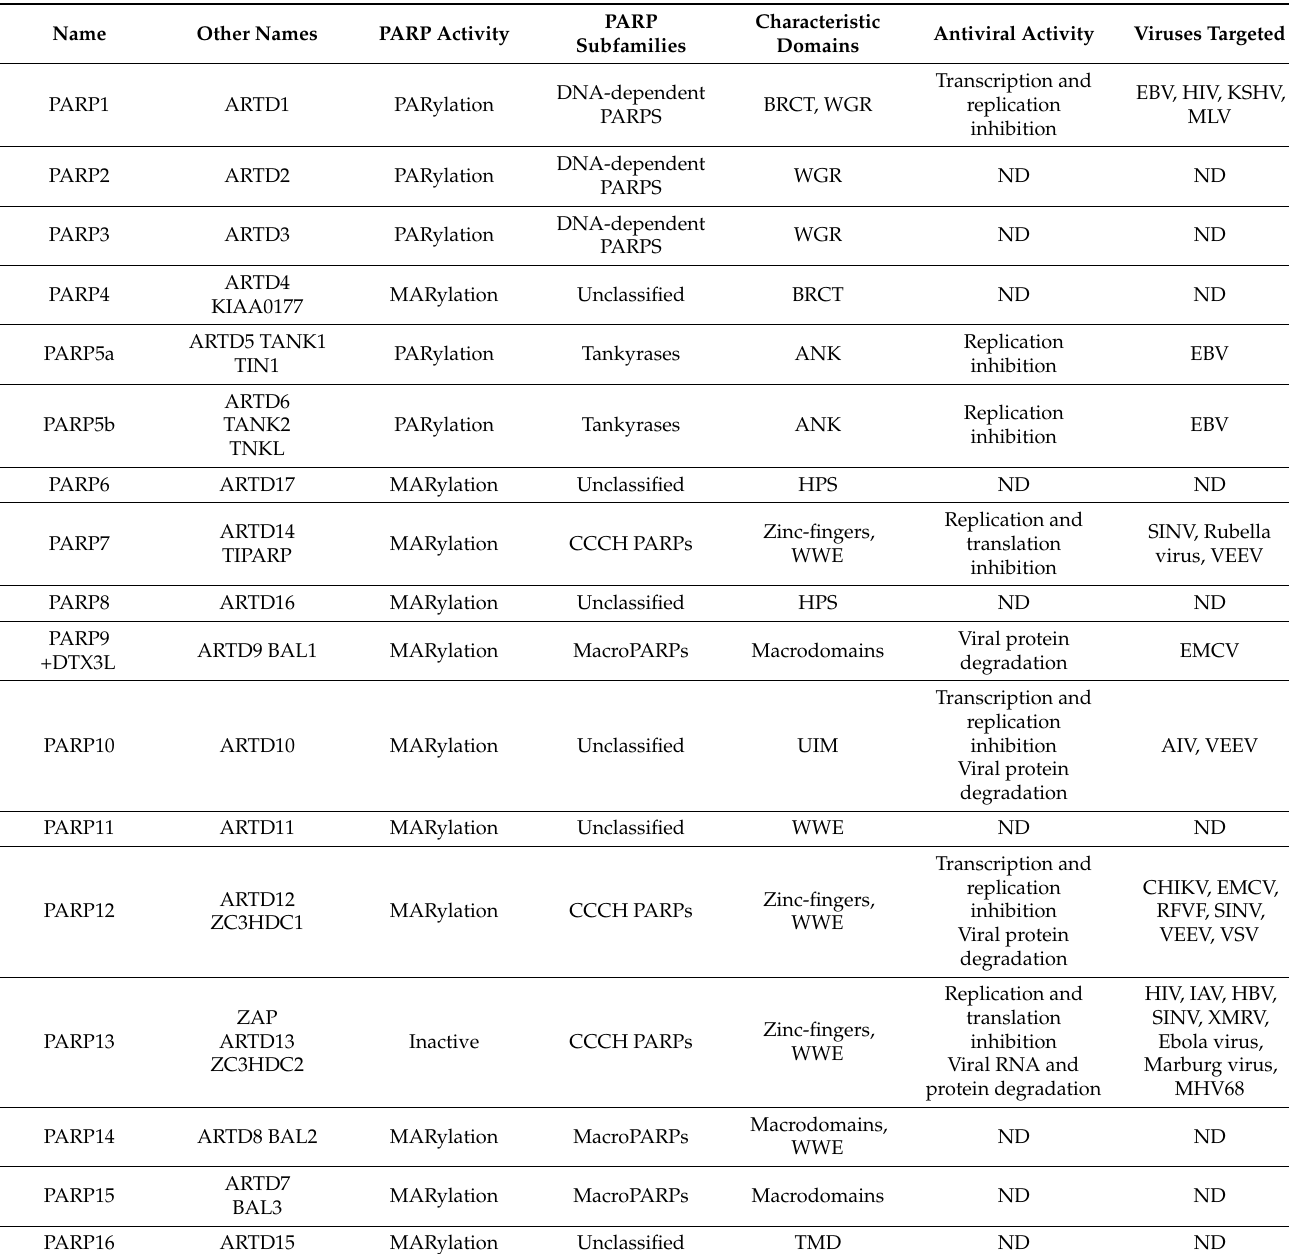
Table 1. Overview of the 17 human Poly-adenosine diphosphate (ADP)-ribose polymerases (PARPs) including alternative names, structural characteristics, antiviral activity, if any, and targeted